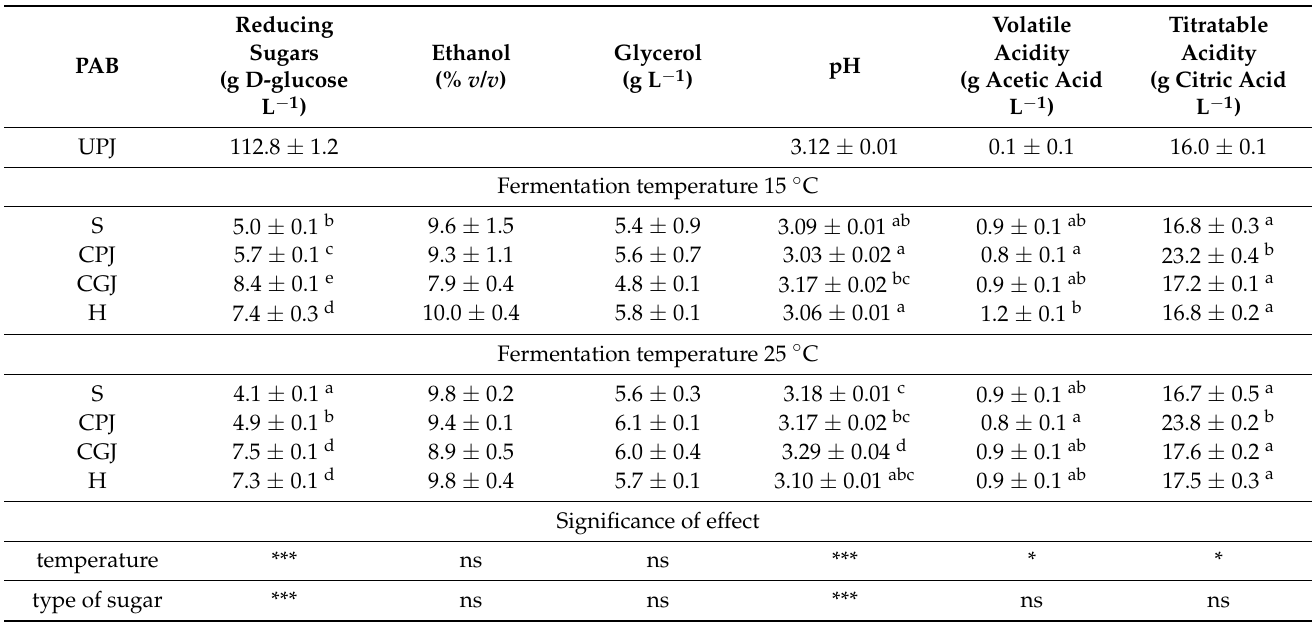
Table 1. Effect of sugar type addition and fermentation temperature on the physicochemical characteristics of PABs.